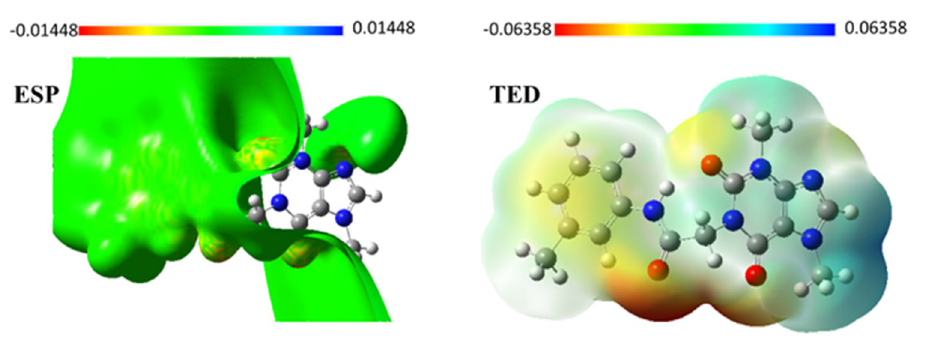
Fig 15. TED and ESP maps of T-1-MTA.